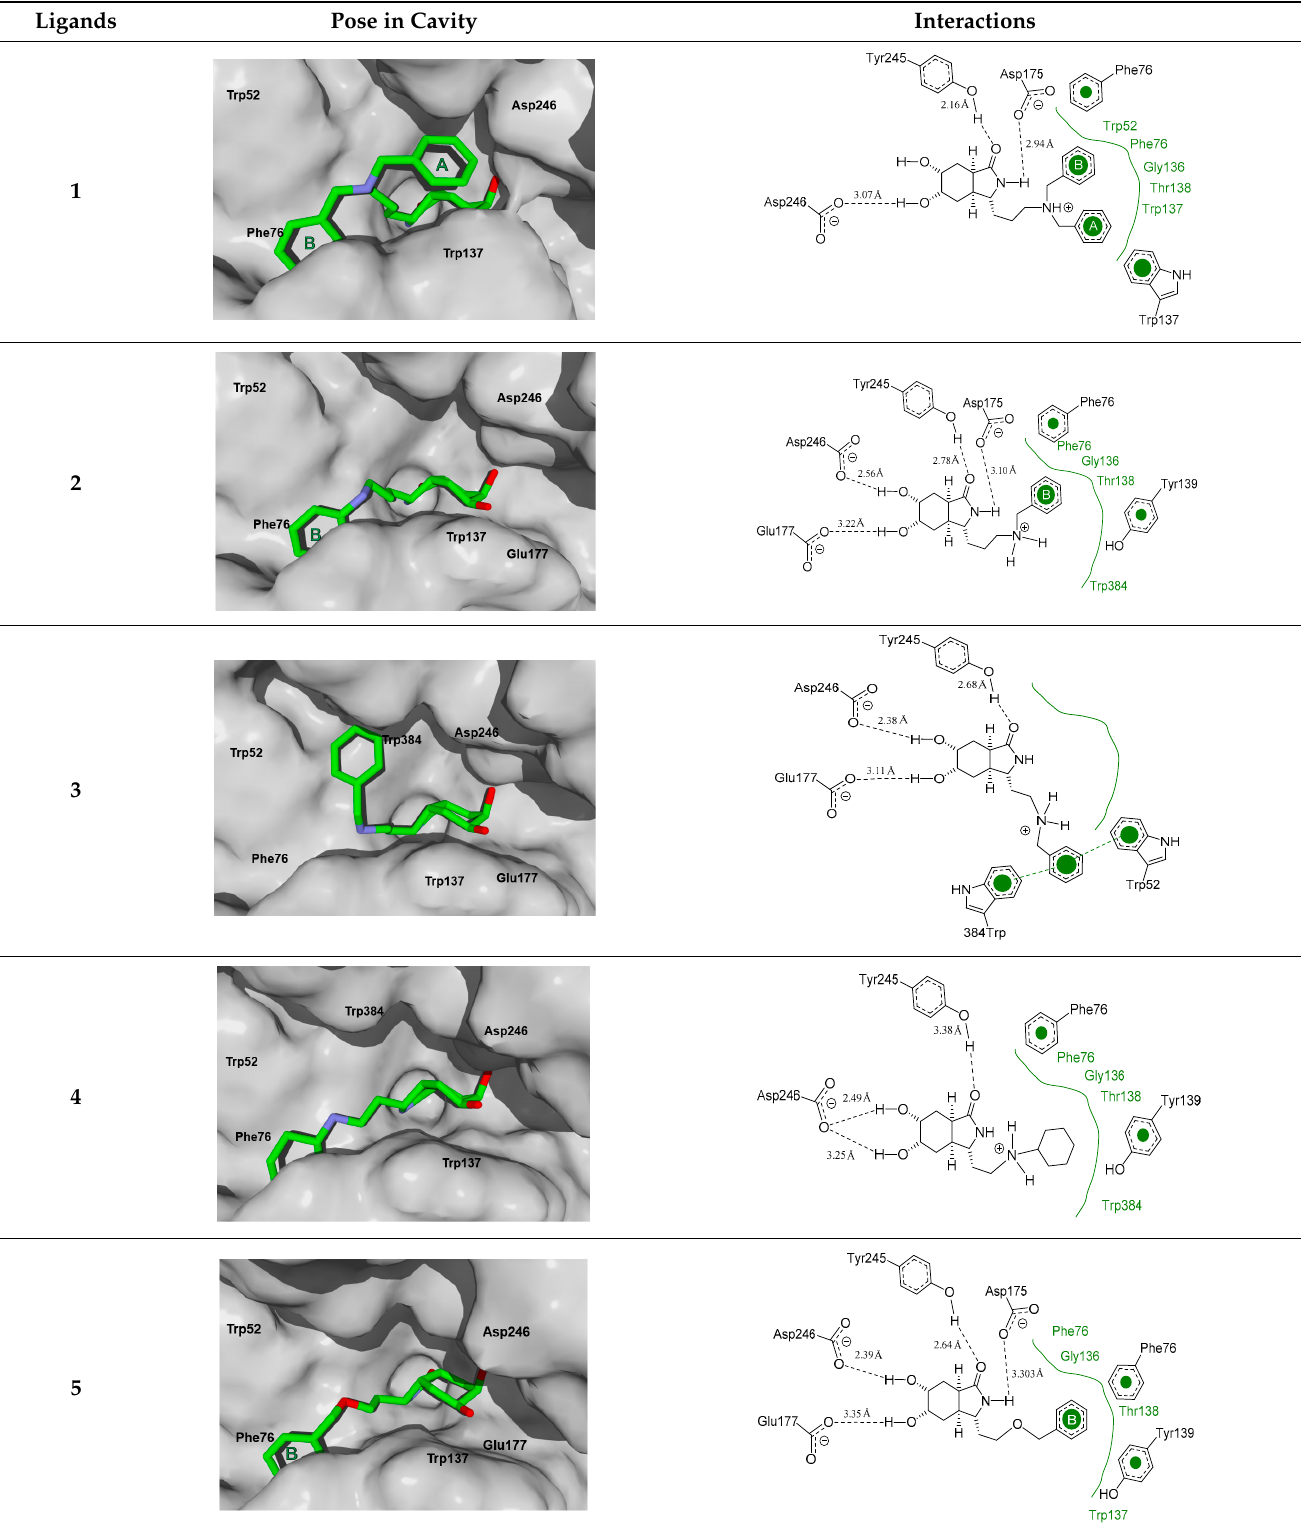
Table 1. Best pose of the best scaffold derivatives (ligands) in AfChiB1.